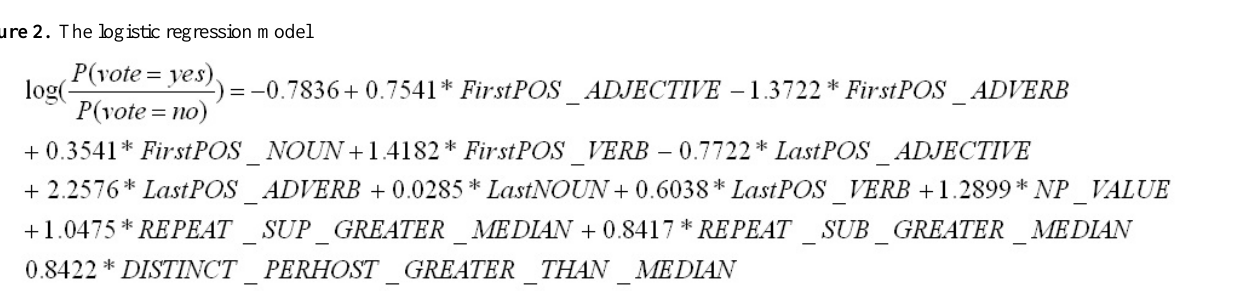
Figure 2. The logistic regression